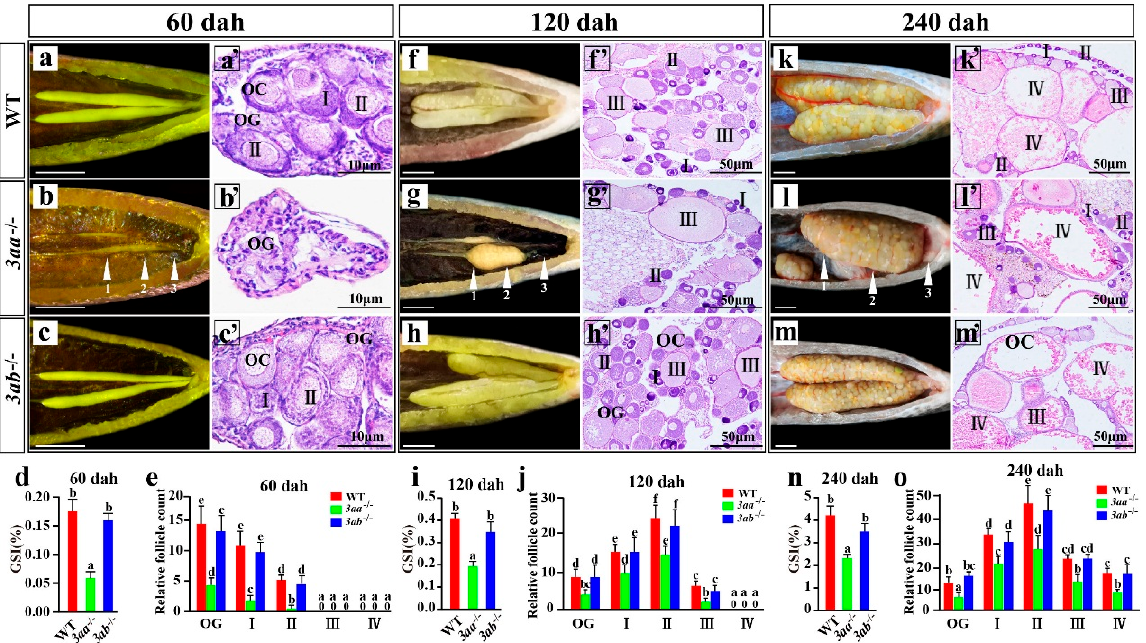
Figure 3. Morphological and histological analyses of WT, dnmt3aa − / − and dnmt3ab − / − ovaries at 60, 120 and 240 dah. ( a – c , a ’– c ’, f – h , f ’– h ’, k – m , k ’– m ’) Morphological and histological observation. ( d , i , n ) Gonadosomatic index (GSI) ( n = 10 for each genotype). ( e , j , o ) Statistical analysis of germ cell counting ( n = 5 for each genotype). Follicles from the median sections (part2) of ovaries were counted for statistical analyses. ( a – c , f – h ) Gonads were fixed with Bouin’s solution. Different letters above the error bar indicate statistical differences at p < 0.05 as determined by one-way ANOVA followed by Tukey’s post hoc test. Results are presented as mean ± SD in ( d , e , i , j , n , o ). Scale bar in ( a – c , f – h , k – m ), 1 cm. dah, days after hatching; OC, oocytes; OG, oogonia; GC, granulosa cells.